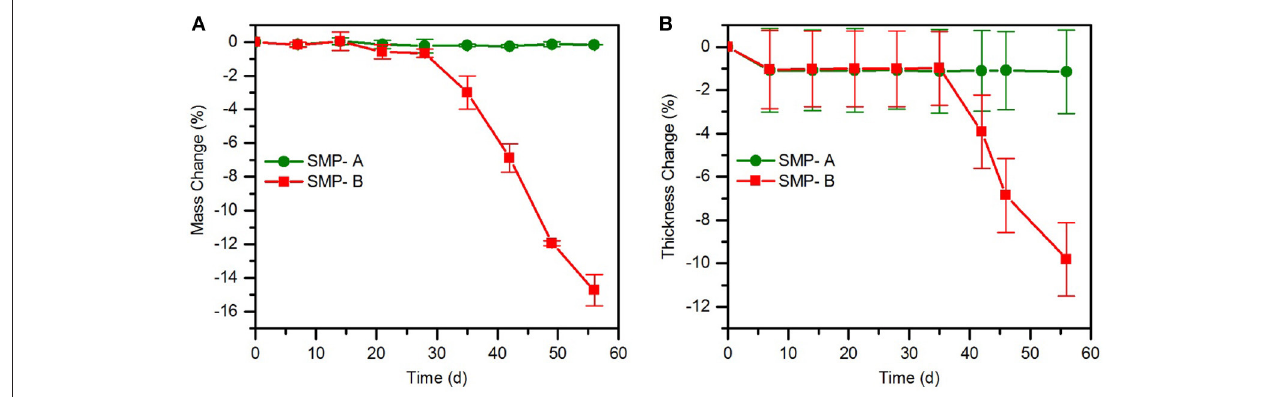
0.3%. In addition to the weight loss study, the thickness of each polymer was monitored during the aging. Figure 5B indicates significant thickness loss (42.1 ± 1.7%) for SMP- B over the course of the aging test, while SMP-A was